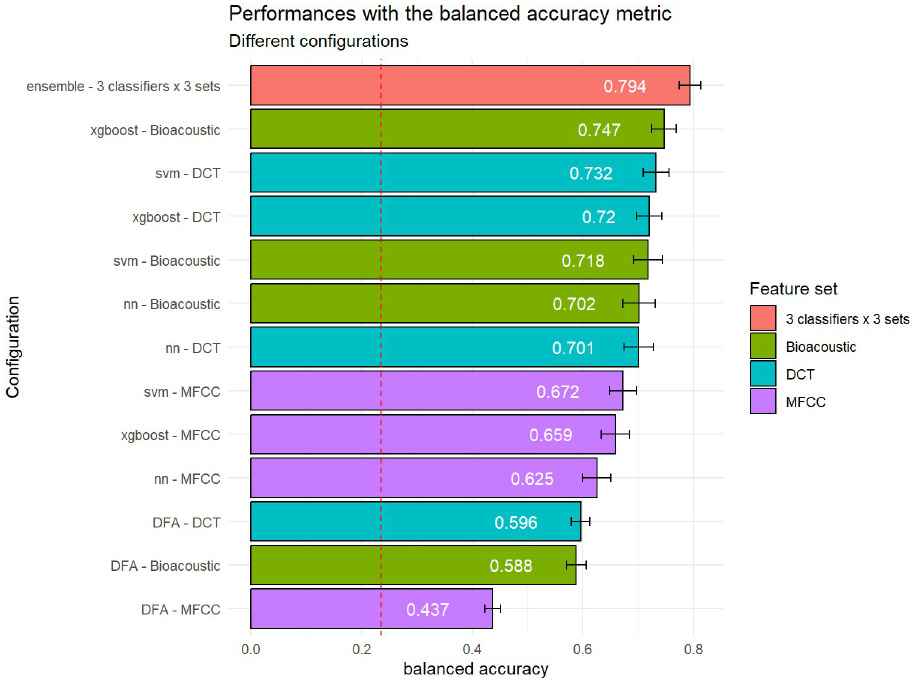
Fig 6. Performance in classifying bonobo call types as a function of classifier and acoustic set used. The red bar shows the performance achieved by an ensemble classifier combining the 9 primary classifiers. The other bars correspond to configurations associating each classifier with different sets of acoustic features (Bioacoustic, DCT, MFCC). The configurations are sorted by decreasing performance from top to bottom. Performance is reported in terms of balanced accuracy. Green, turquoise, and purple indicate the models trained on the Bioacoustic, DCT, and MFCC feature sets respectively. Chance level is represented by the vertical dashed red line. The error bars report the standard deviation of the performances for the 100 iterations of the evaluation